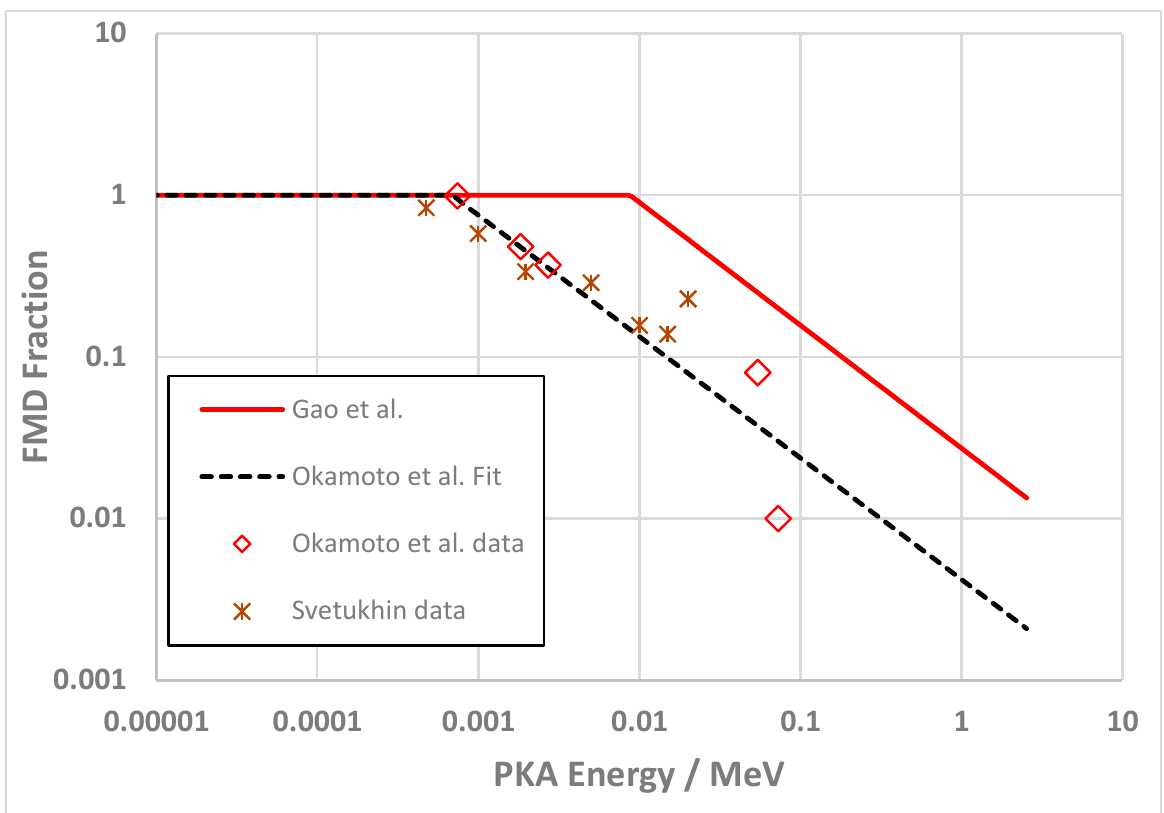
Figure 6. FMD fraction for Ni as a function of cascade energies for the different PKA values data form